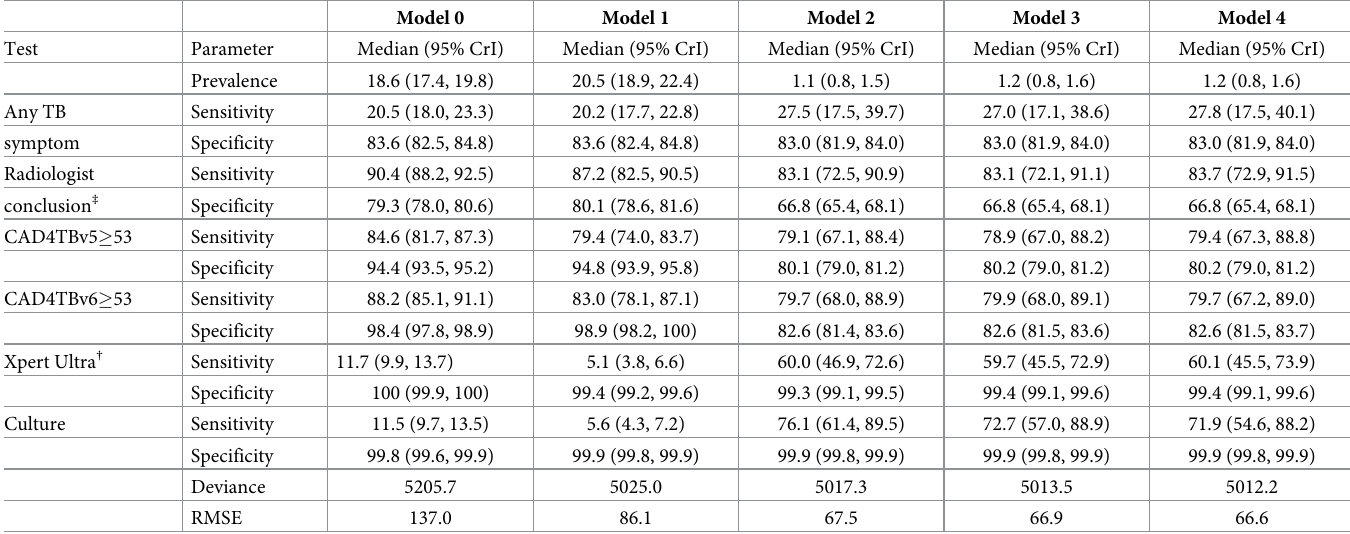
Table 3. Posterior median and 95% credible intervals (95% CrI) of the prevalence and diagnostic test sensitivity and specificity of Vukuzazi